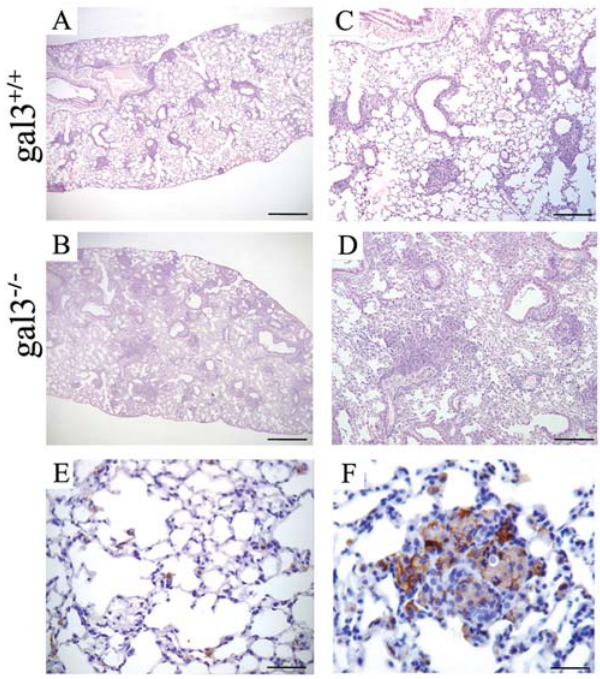
Figure 2. Histopathology and immunohistochemistry staining for galectin-3 in lung sections from P.brasiliensis -infected gal3 + / + and gal3 2 / 2 mice. Mice were intraperitoneally infected with 5 6 10 6 yeasts cells and their lungs were analyzed after 30 days. Lungs of gal3 + / + mice show well-organized granulomas (A and C). Gal3 2 / 2 mice present a diffuse pattern of inflammatory cells, with incipient granuloma formation (B and D). Galectin-3 staining increases after infection with the fungus, mostly detected in the inflammatory cells of the granulomas and surrounding yeast cells (F). Galectin-3 is barely noted in the lungs of non-infected control mice (E). Sections were stained with H&E (A–D) or immunostained for galectin-3 with a hematoxilin counterstain (E–F). Scale bars on panels A and B indicates 1 mm; on C and D 400 m m, and on E and F 100 m m.